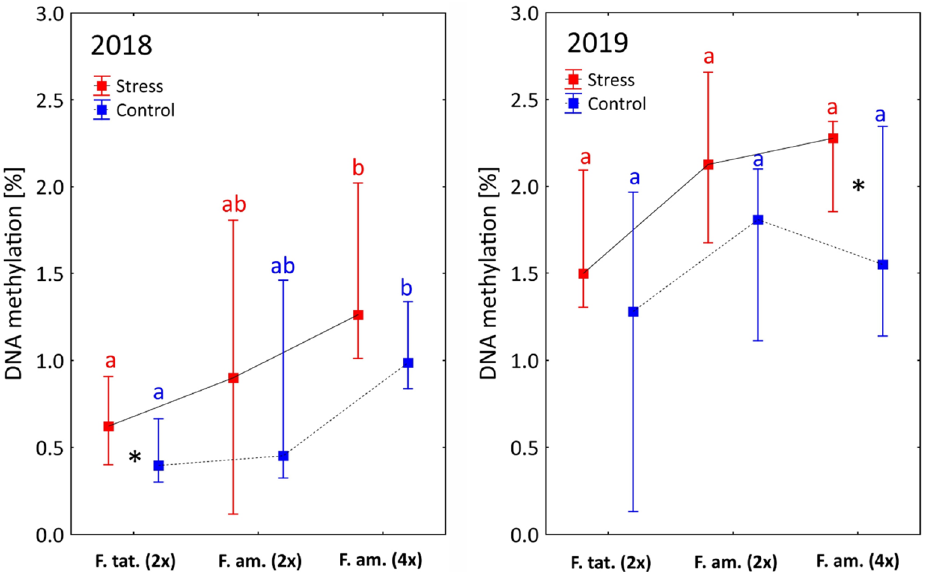
Figure 1. Global DNA methylation level for species (and cytotypes) in a given year and sampling conditions (stress vs. control). Squares—median values; whiskers—upper and lower quartile. Letters denote statistical significance (< 0.05) of DNA methylation level between species/cytotypes in the same year and the same sampling conditions, according to the non-parametric Kruskal–Wallis test. An asterisk indicates significant (p < 0.05) differences in DNA methylation levels between stress and control conditions within the species/ cytotype in the same year according to the Wilcoxon pairwise test.